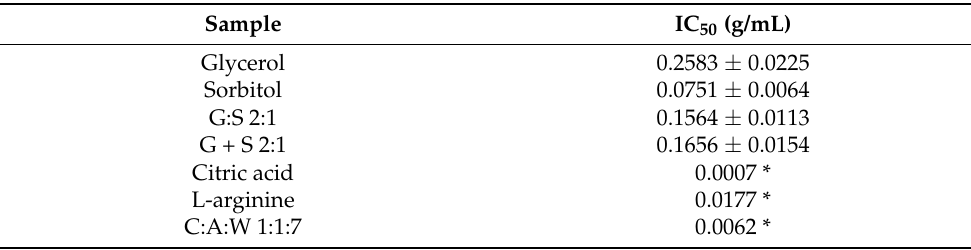
Table 1. IC 50 determined for glycerol, sorbitol, G:S 2:1, and G + S 2:1 (molar ratio), represented in mean ± SD. * The IC 50 values for citric acid, L-arginine, and C:A:W 1:1:7 were determined elsewhere [18] in a CACO-2 cell line.